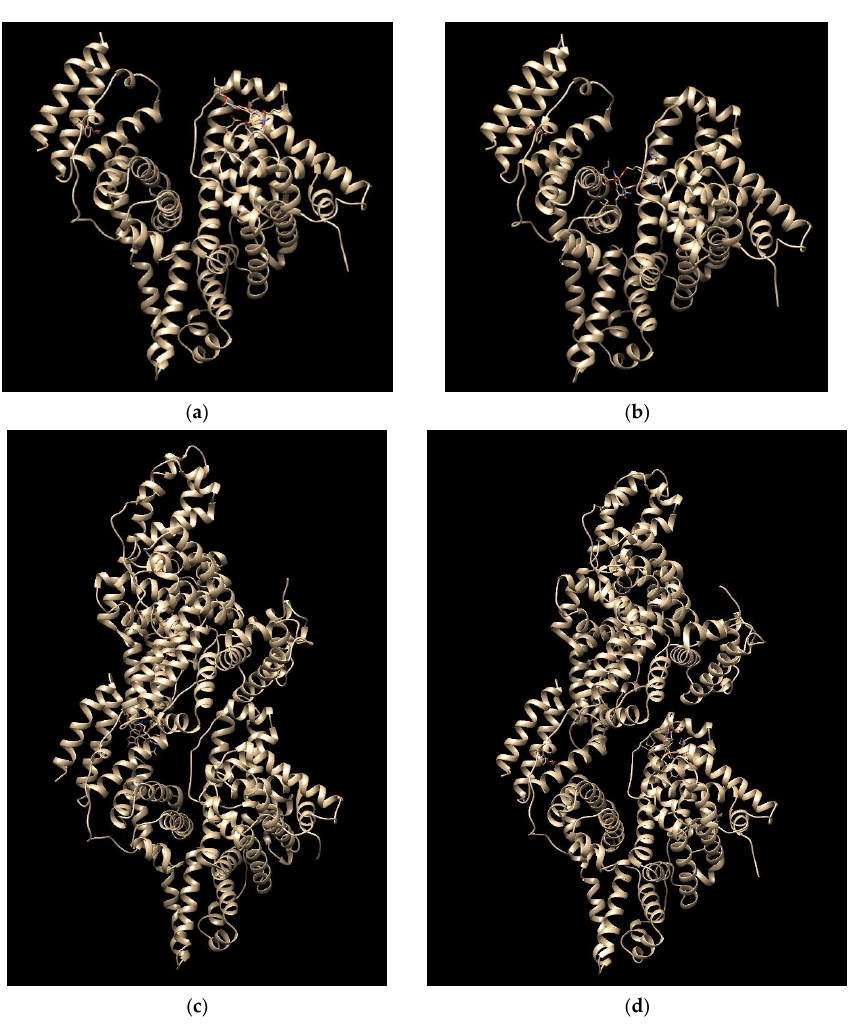
Figure 5. The docked structure of the BDF1/BSA ( a , c ) and BF1/BSA ( b , d ) complexes with the monomer ( a , b PDB ID: 4f5s, chain: A) and dimer ( c , d PDB ID: 4f5s, chains: A,B) protein targets.